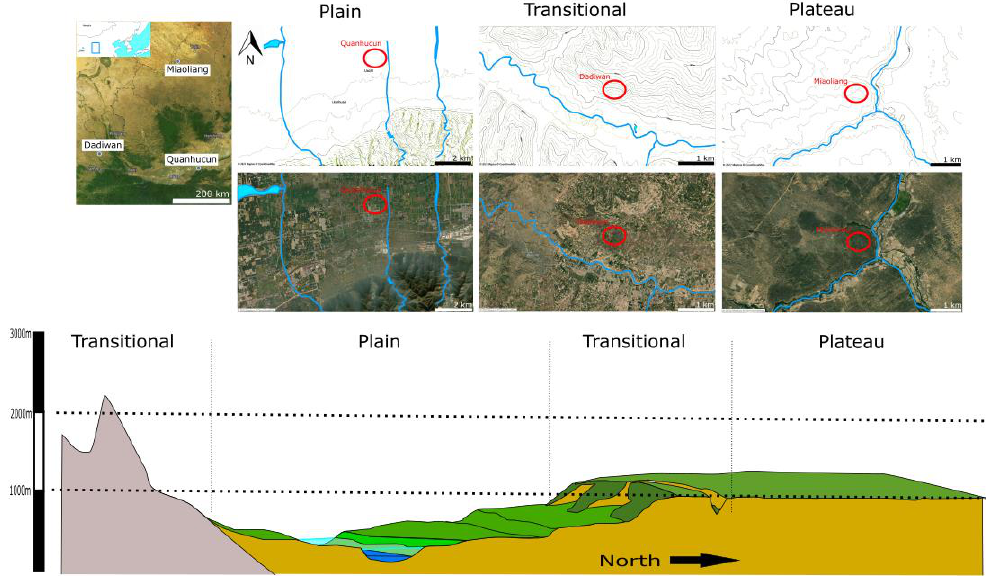
Figure 3. Landscape definitions, with the sites of Quanhucun, Dadiwan, and Miaoliang as examples. (Tableau and Inscape, F. Monteith).